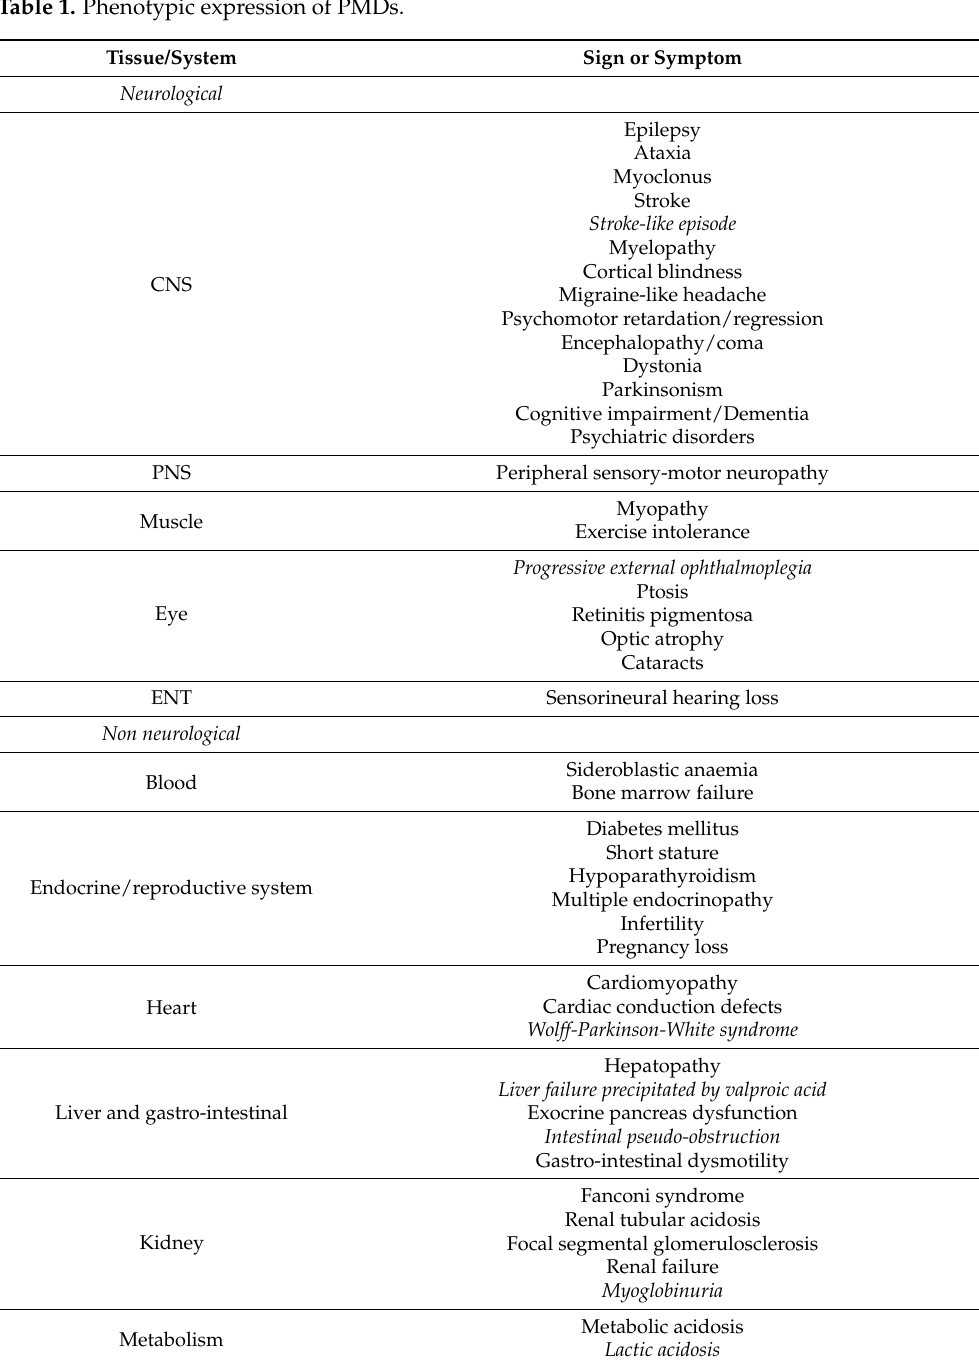
In italics: peculiar signs/symptoms (‘red flags’) suggestive of